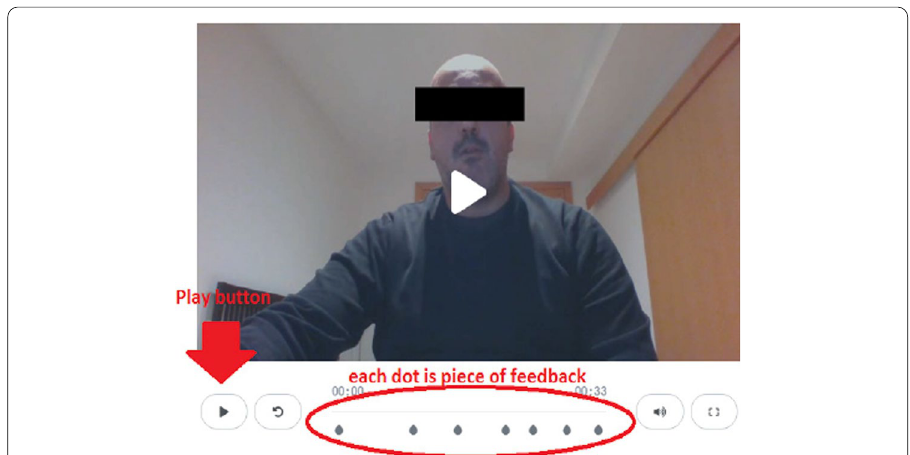
Fig. 2 Example of a video with feedback incorporated using Edpuzzle for S2 JN in study 1. Note: Each dot represents a piece of personalised feedback about the pronunciation target except for the first dot which is an introduction to the task made by the tutor